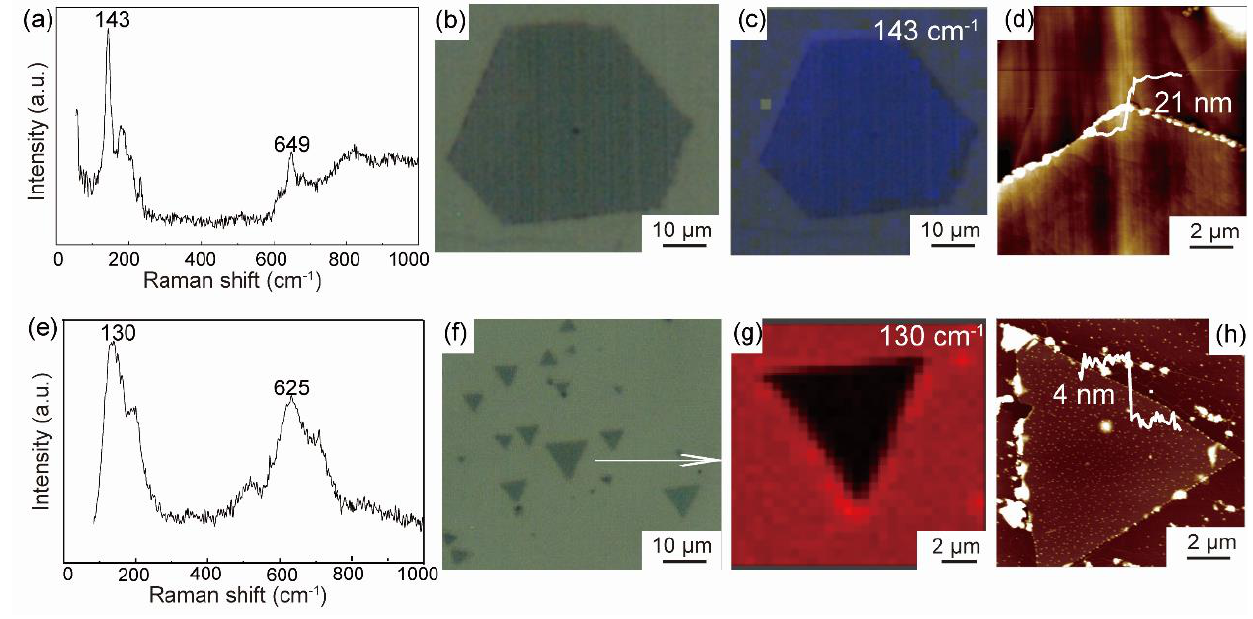
Figure 4. Raman spectra ( a , e ), optical images ( b , f ), Raman mapping ( c , g ) and AFM images ( d , h ) of orthorhombic ( a – d ) and cubic ( e – h ) MTC phases.